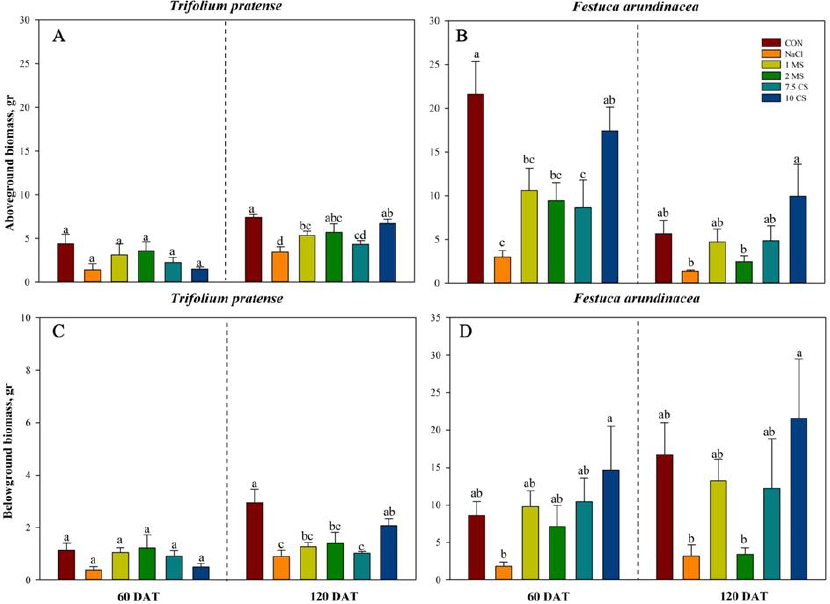
Figure 2. Evaluation of T. pratense ( A , C ) and F. arundinacea ( B , D ) by analyzing aboveground biomass and root biomass under six different treatments. Plants were treated with 100 mM NaCl solution; 1 mM MgSO 4 + 100 mM NaCl (1 MS); 2 mM MgSO 4 + 100 mM NaCl (2 MS); 7.5 mM CaSO 4 + 100 mM NaCl (7.5 CS); 10 mM CaSO 4 + 100 mM NaCl (10 CS), within calculated 60 DAT, and 120 DAT. Vertical bars represent standard errors ( N = 4). Different lowercase letters indicate significant differences among the treatments at α = 0.05.